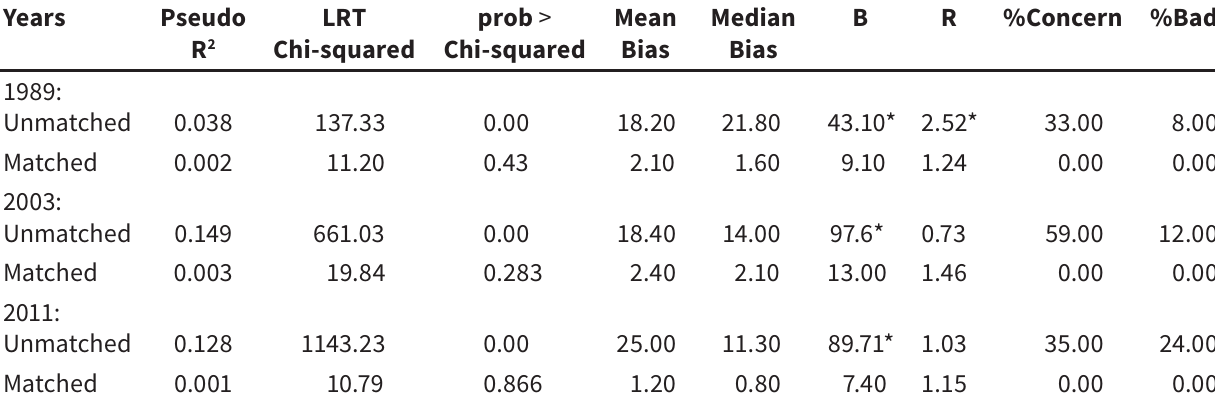
Pre-war and Post-war Balancing Property Diagnostics